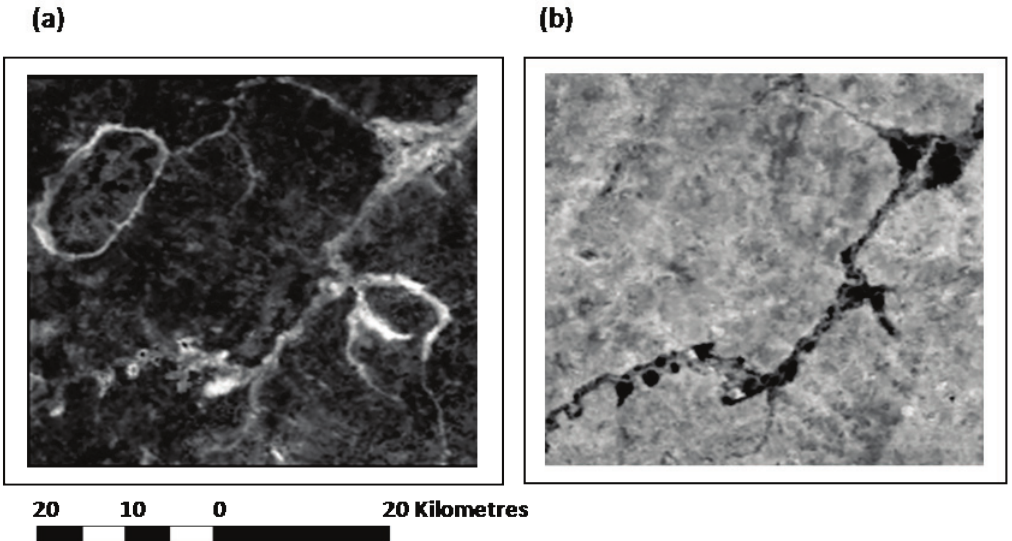
Figure 2. The La Mare Hippotames wetland in Burkina Faso. (a). the MODIS vegetation index, VI, mean from Julian day 310 to Julian day 358 (dry season), for the calendar year 2002. (b). the corresponding MODIS near-infrared, NIR, reflectance mean from Julian day 167 to 215 (wet